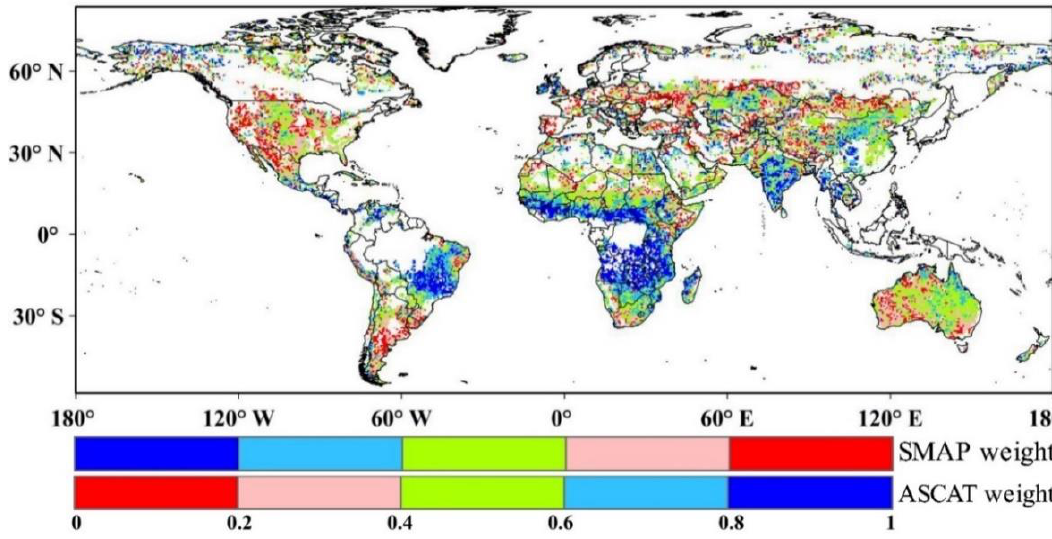
Figure 5. The spatial distribution of the global optimal weights for parent SM products (SMAP and ASCAT) of the SMAP+ASCAT merged dataset.